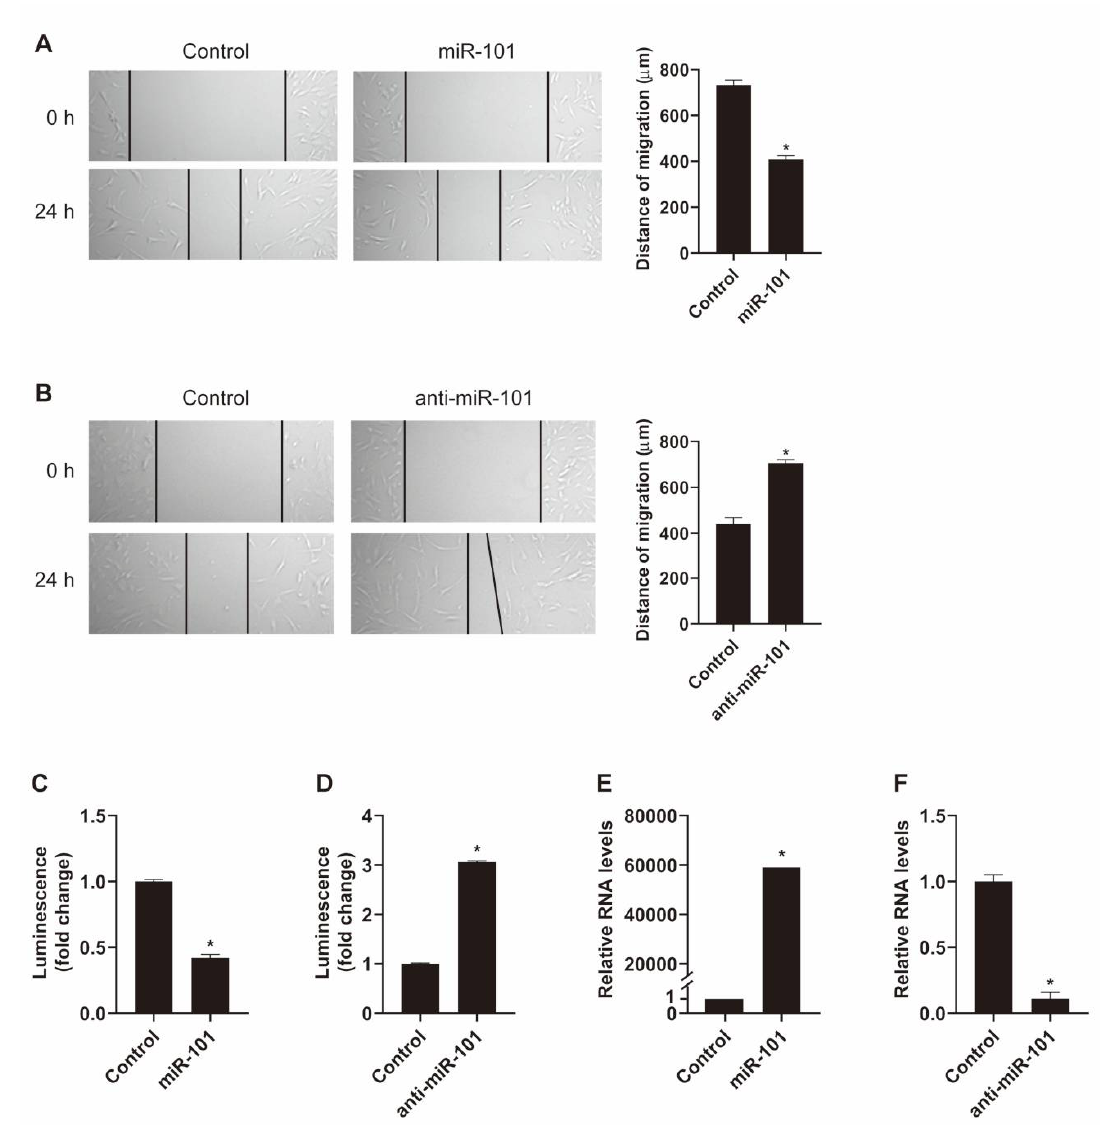
Figure 1. miR-101 regulates vascular smooth muscle cell (VSMC) functions. ( A , B ) Pulmonary artery smooth muscle cells (PASMCs) transfected with control, miR-101 mimic ( A ), or anti-miR-101 ( B ) were subjected to the scratch wound assay. The distance of the migration was measured using ImageJ at 24 h after a scratch wound was introduced. The left panel shows representative images, and the right panel shows the quantification graph of the migration distance. The means ± S.E. of triplicate measurements of three independent experiments are shown. *, p < 0.05. ( C , D ) Luminescent signals for viable PASMCs transfected with control, miR-101 mimic ( C ), or anti-miR-101 ( D ) for 3 days. *, p < 0.05. ( E , F ) Levels of miR-101 relative to U6 snRNA measured by qRT-PCR in PASMCs 24 h after transfection of control, miR-101 mimic ( E ), or anti-miR-101 ( F ) The data represent the means ± S.E. of triplicates. *, p < 0.05.